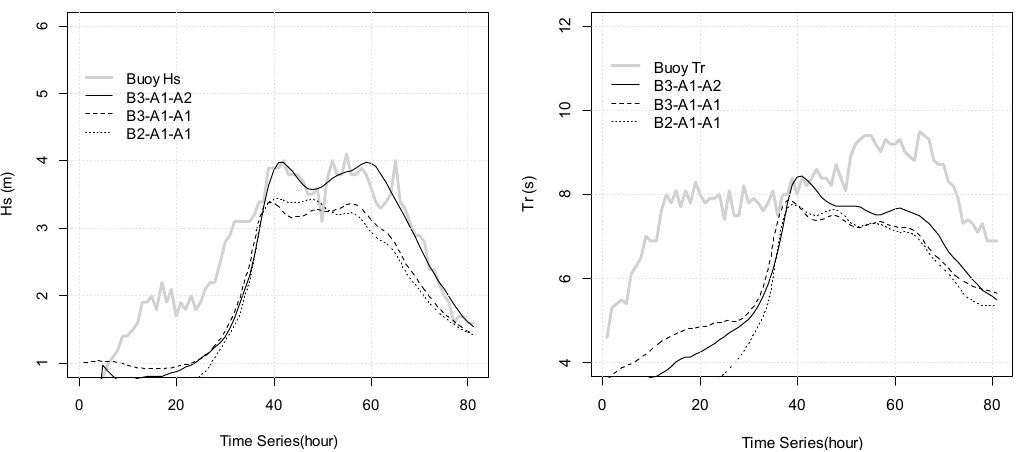
Figure A2. Comparison of typhoon waves induced by Typhoon Nock-ten (08-2011) at buoy QF302: the standard H10 is indexed as B2-A1-A1, the model with varying parameter b without an asymmetric typhoon structure is indexed as B3-A1-A1, and MH10 is indexed as B3-A1-A2.